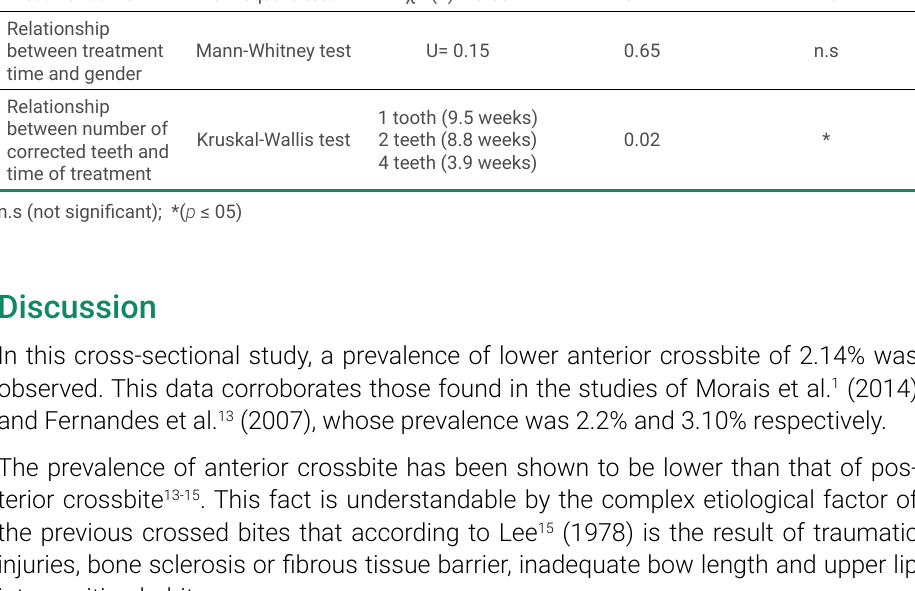
Table 2. Variables studied in the 12 treated children Variables Test Valor p valor Significance Difference between the genders Treatment